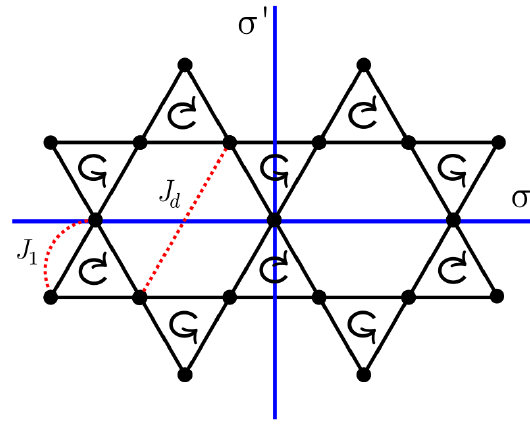
Figure 1: Schematic representation of the kagome model with Heisenberg exchange interactions J and J and chiral three-spin interaction J χ . The staggered chirality d 1 is represented by the arrows inside the triangles. The reflection axes σ and σ (cid:48) are indicated by blue solid